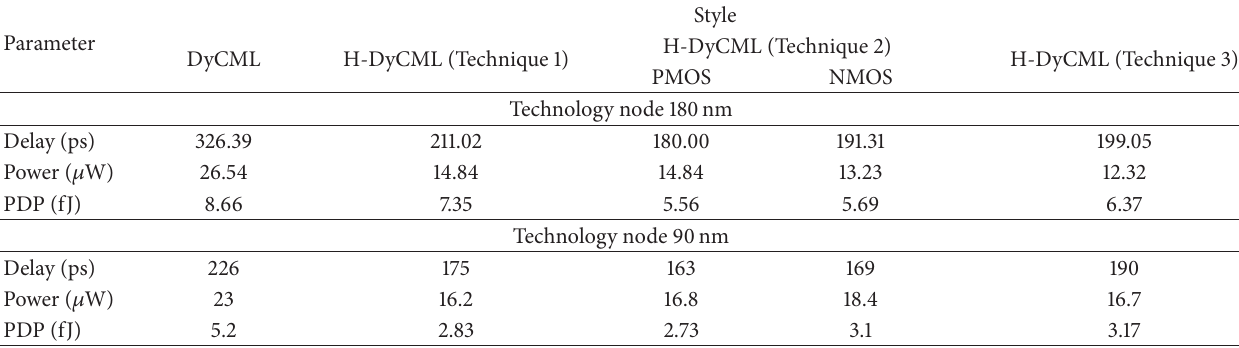
Table 4: Performance comparison of the existing DyCML and the proposed H-DyCML 3-input XOR gate with two levels of source-coupled transistors in the